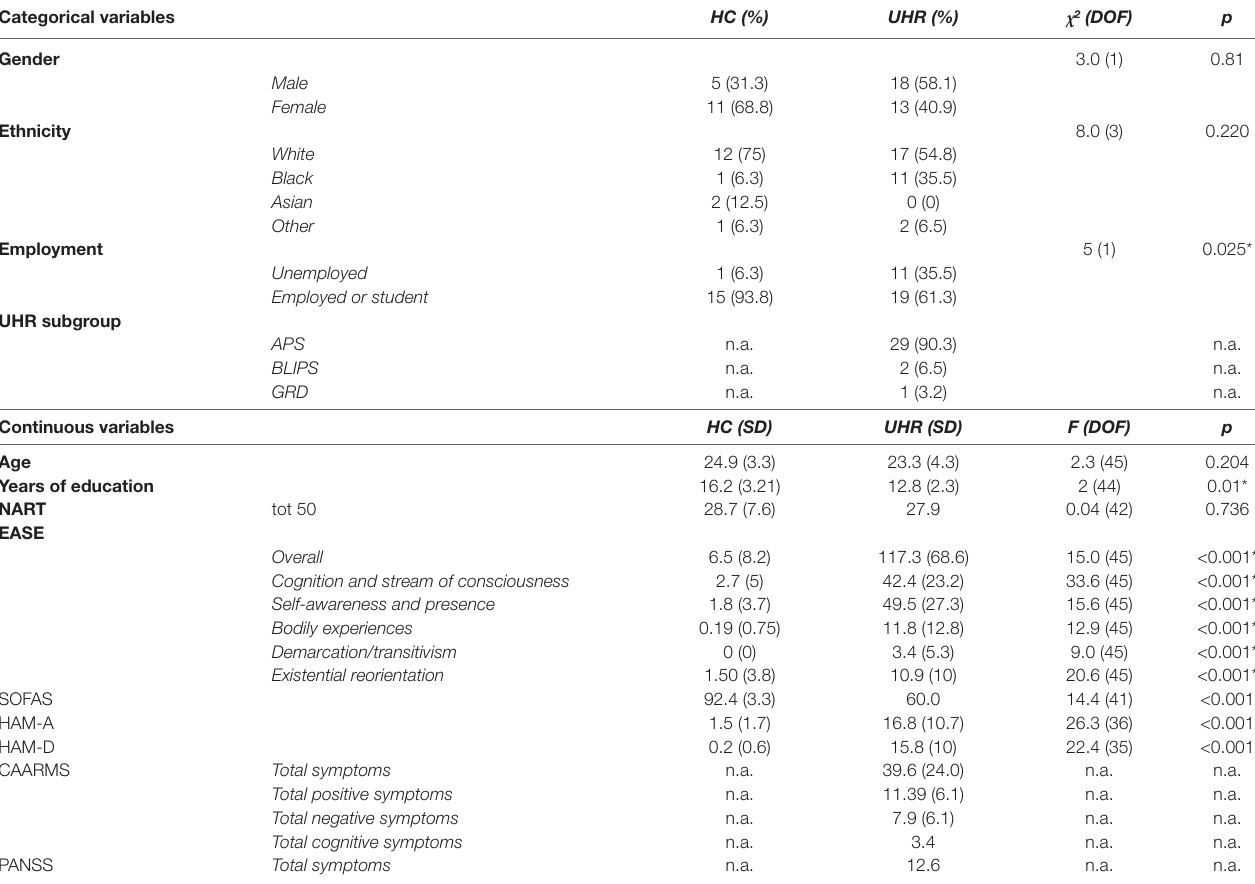
TABLE 1 | Clinical and sociodemographic characteristics of the sample. Categorical